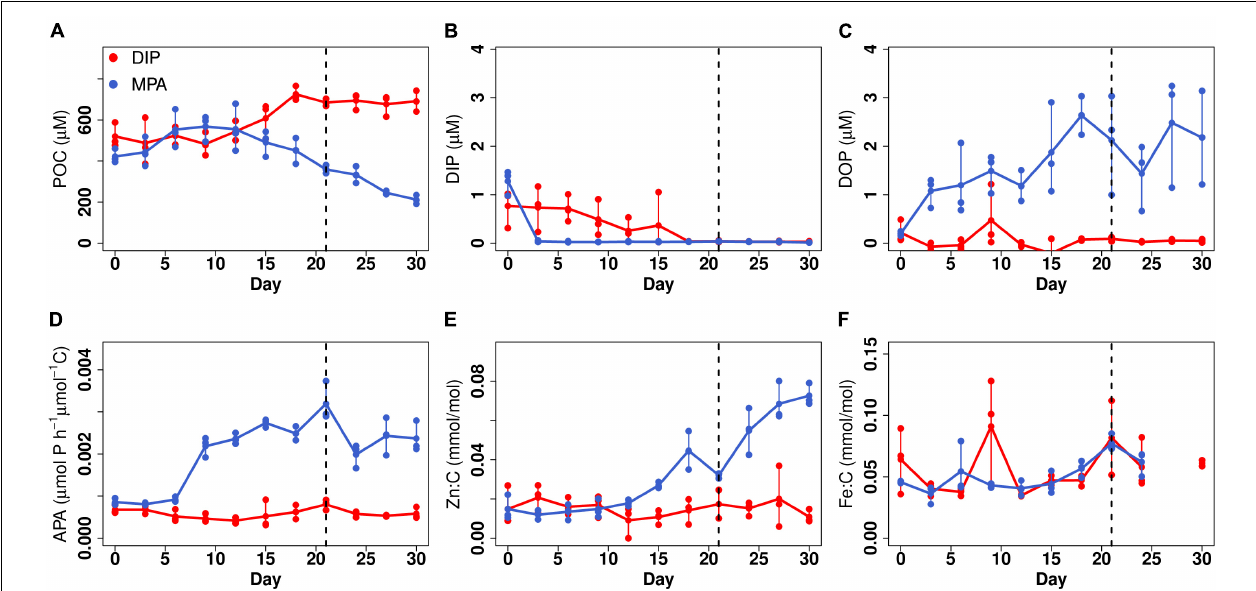
FIGURE 1 | Responses of Trichodesmium ISM101 to DIP and MPA treatment. (A) Particulate organic carbon (POC). (B) Dissolved inorganic phosphorus (DIP). (C) Dissolved organic phosphorus (DOP). (D) POC-normalized APA. (E) Zn:C ratio. (F) Fe:C ratio. Points show triplicate measurements every 3 days; lines map change in mean value with time. Time to right side of dashed line is considered to be steady-state.